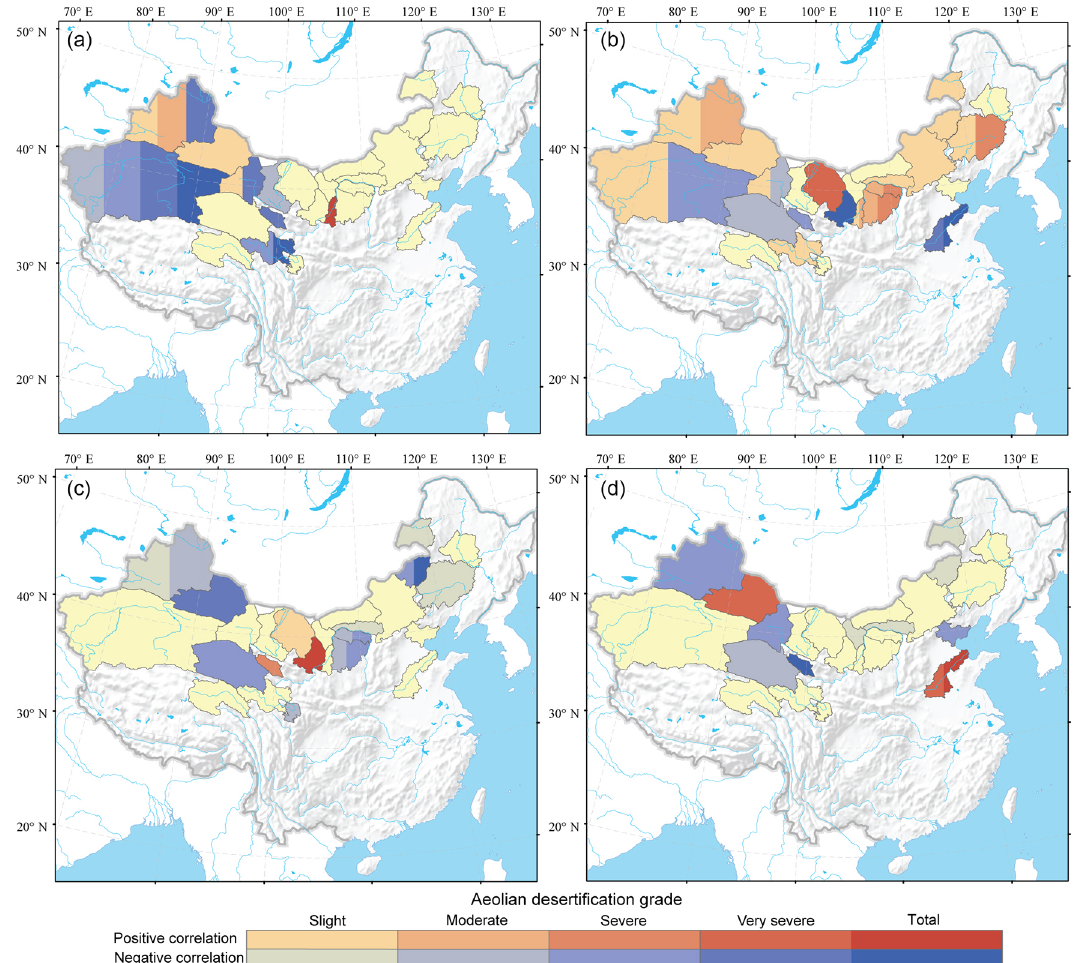
Figure 1. Spearman correlations between variations in areas of aeolian desertification and (a) rainfall, (b) temperature, (c) wind speed, and (d) the Palmer Drought Severity Index (PDSI). Main areas where aeolian desertification monitoring takes place are shown in Fig. S2. Regions where negative/positive correlations are significant at the 0.05 level (two-tailed) are shown in blue/red, and regions where correlations were not significant at the 0.05 level (two-tailed) are shown in yellow. Detailed correlation results are provided in Table